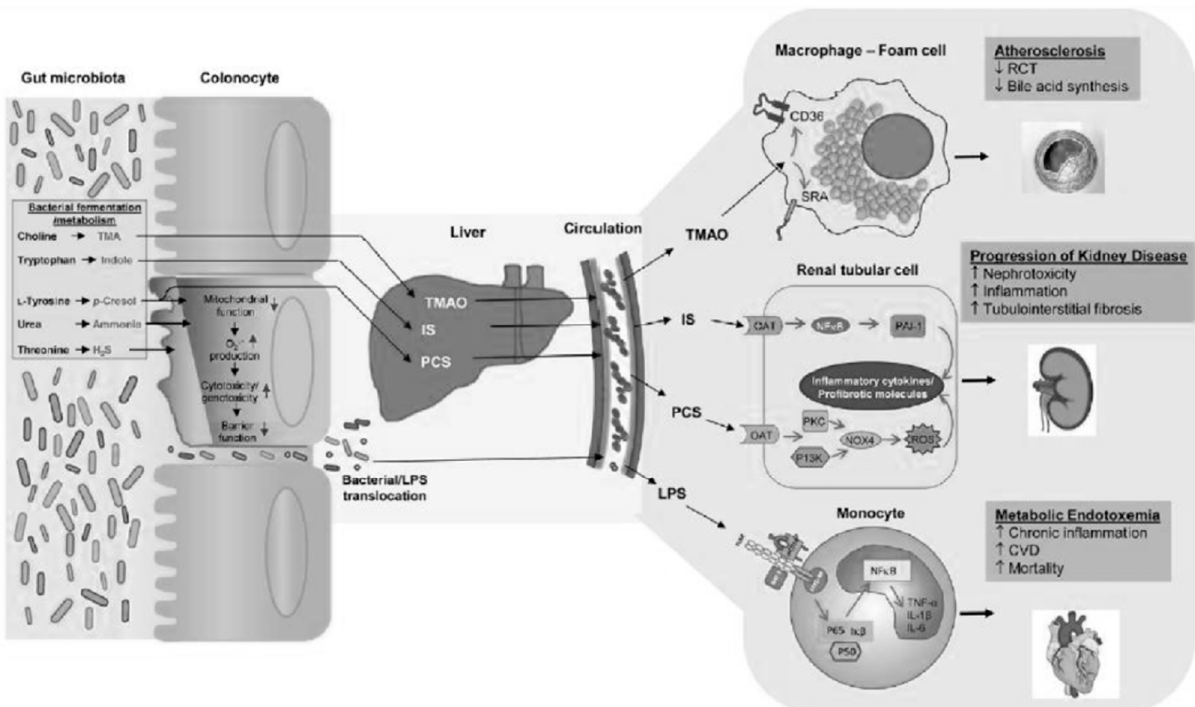
Figure 5. Ramenzani et al.: Role of the gut microbiome in uremia: a potential therapeutic target- AJKD, 2016.